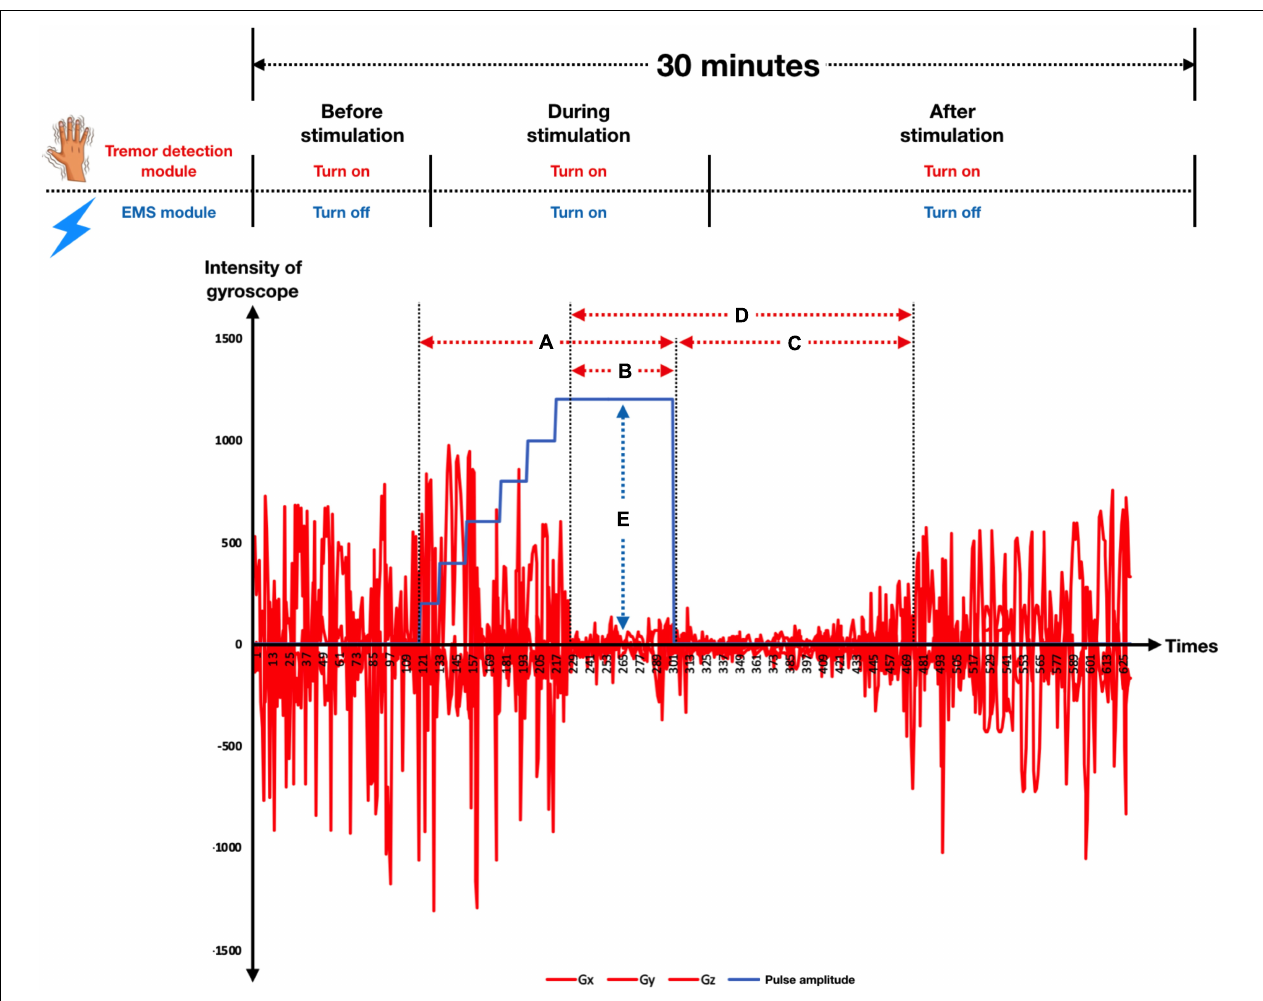
FIGURE 3 | The temporal pattern of the experiment is illustrated, including the period of tremor detection and EMS, as well as tremor reduction outcomes. In this study, we divided the experiment into 3 sections, including (1) before stimulation, (2) during stimulation, and (3) after stimulation. The red line denotes the intensity of the gyroscope (x, y, and z), while the blue line refers to the pulse amplitude. Black dashed lines represent time boundaries. The duration of stimulation is indicated by (A) , while (B) shows the duration of tremor reduction during stimulation. The duration of continuing tremor reduction after withdrawal of EMS until the tremor re-emerged to the pre-stimulation tremor level is shown by (C) , while (D) indicates the tremor reset time and (E) represents Pulse